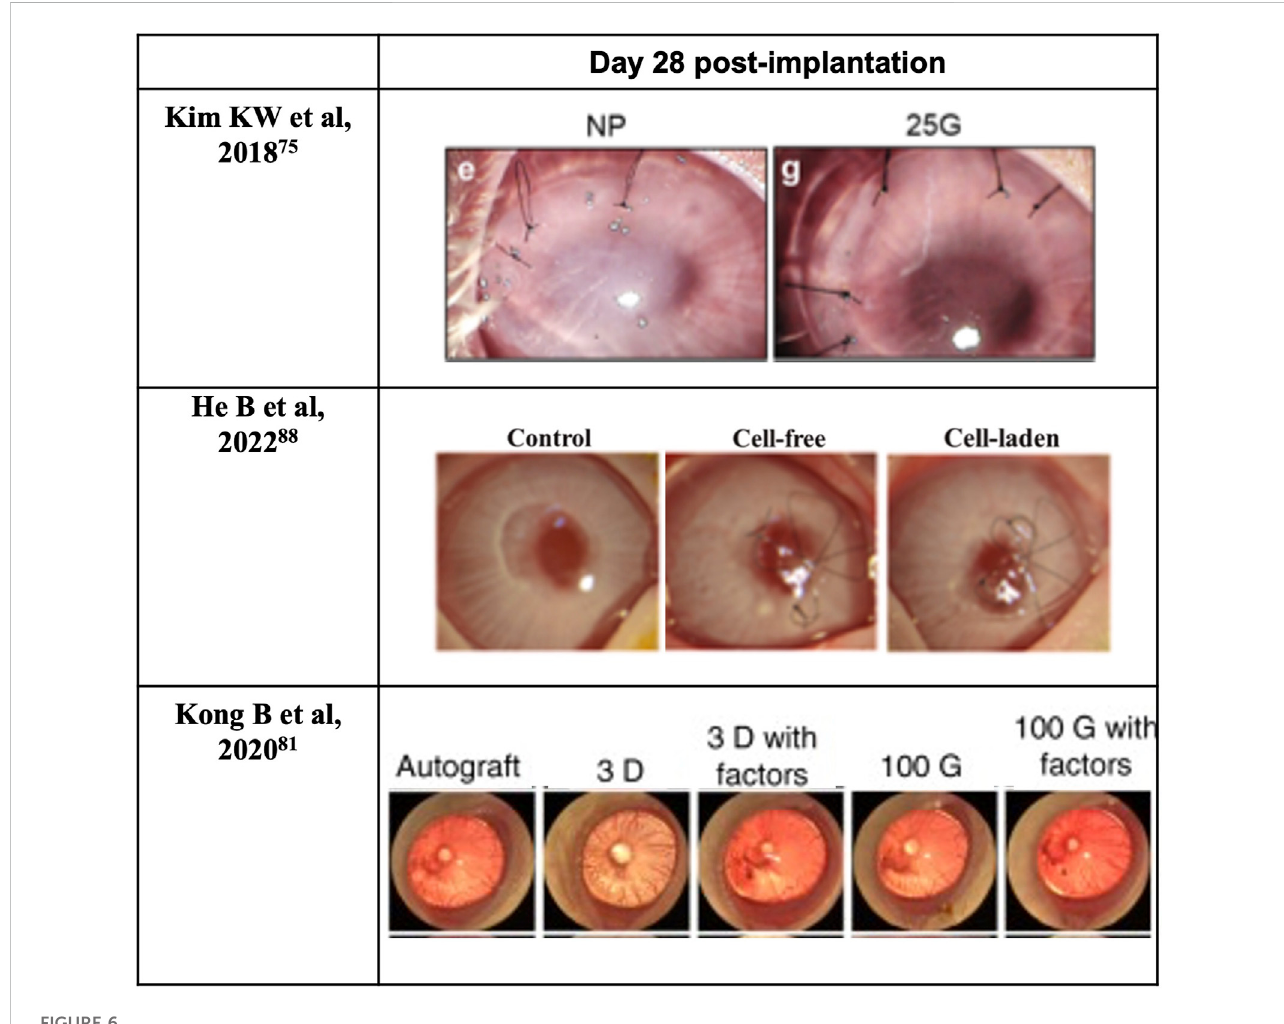
FIGURE 6 Surgical applications of 3D bioprinted